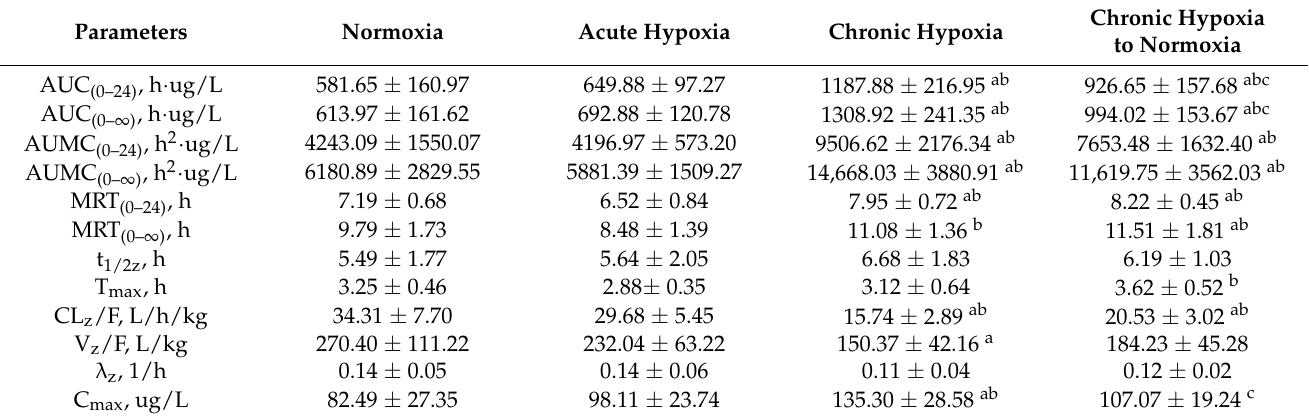
Table 7. Pharmacokinetic parameters of bosentan in rat plasma after exposure to high-altitude hypoxia.